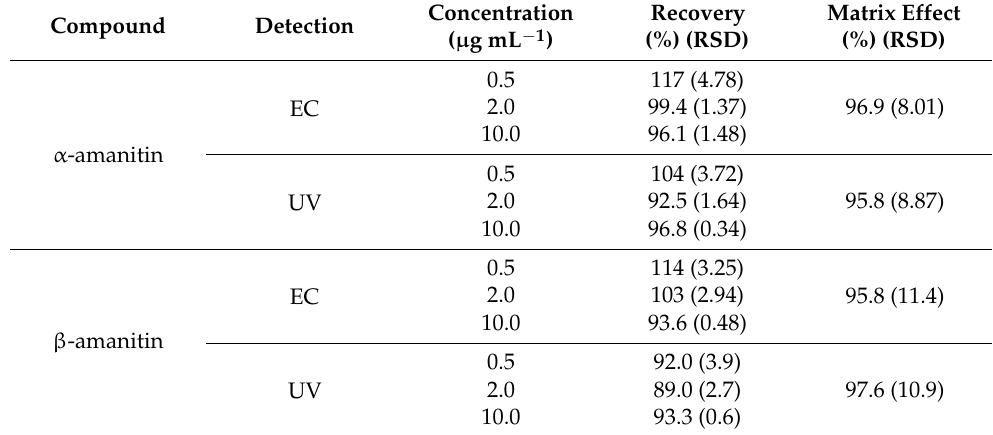
Table 3. Recovery and matrix effect values for α - and β -amanitin analyzed by HPLC-UV-EC. Compound